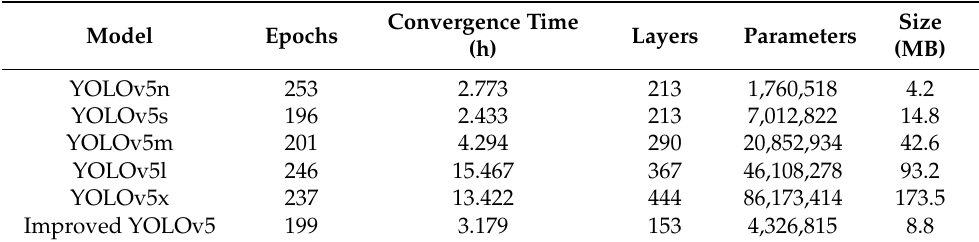
Table 4. Training information of different YOLOv5 models.